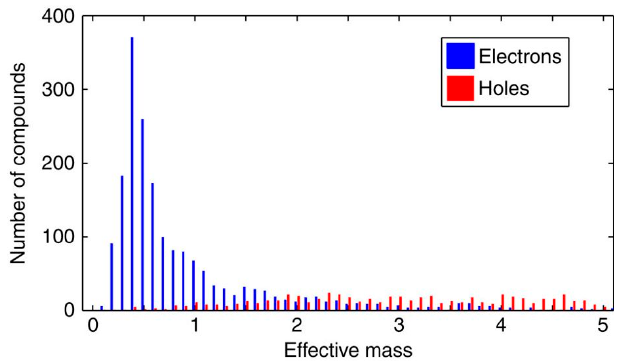
Figure 1. Effective mass distribution of both electrons and holes in selected binary and ternary oxides. Reproduced with permission from Ref. [12]. Copyright 2013 Springer Nature.